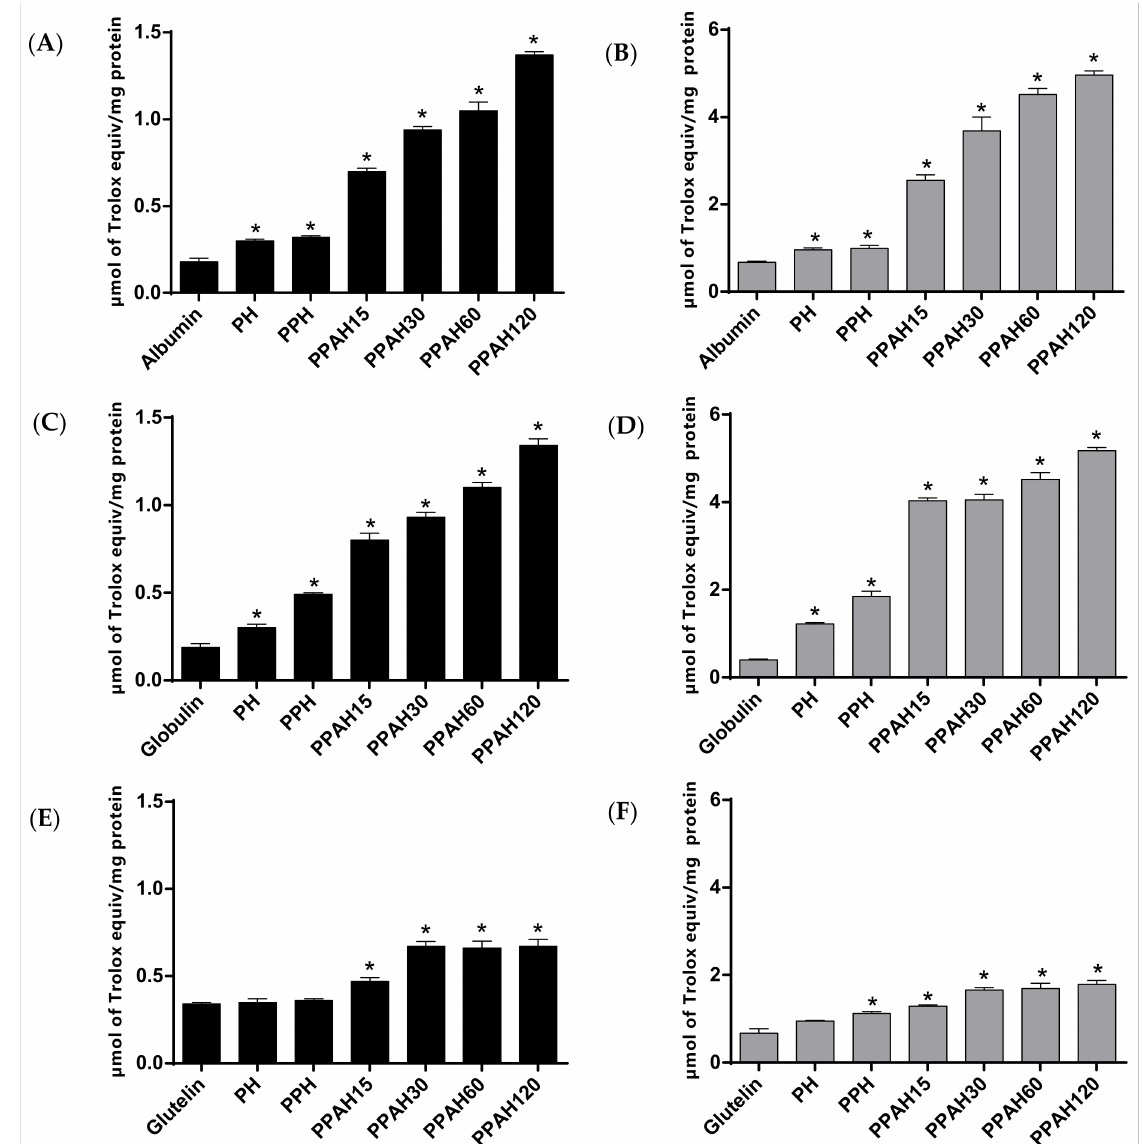
Figure 3. ABTS • + ( A , C , E ) and peroxyl ( B , D , F ) radical scavenging capacity (expressed as µ mol Trolox equivalents/mg of protein) of hydrolyzates from ( A , B ) albumin, ( C , D ) globulin, and ( E , F ) glutelin with pepsin (PH), pepsin + pancreatin (PPH), and pepsin + pancreatin + alcalase for 15 min (PPHA15), 30 min (PPHA30), 60 min (PPHA60) and 120 min (PPHA120). * p > 0.05 vs. protein